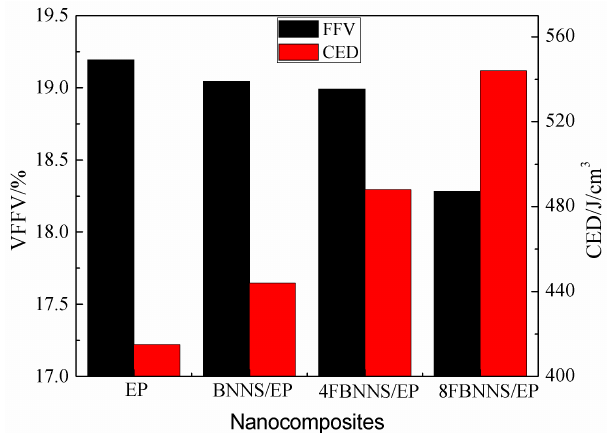
Figure 11. Cohesive energy density (CED) and valid free volume fraction (VFFV) of BNNS / EP nanocomposites.